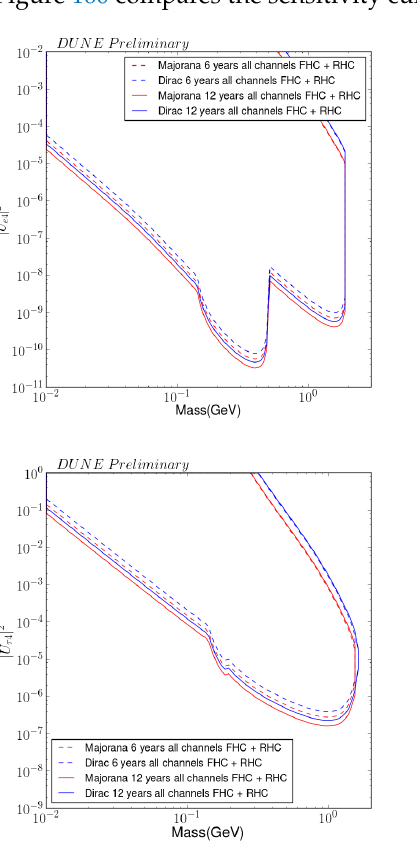
Figure 159. The 90% confidence level (CL) sensitivity regions for dominant mixings 2 are presented for DUNE ND. Sensitivity curves are shown that are reached after 6 and U τ N and | | 12 years of data taking using an equal amount of beam time in the neutrino and anti-neutrino configuration. The regions are a combination of the sensitivity to HNL decay channels with good ν ee , ν e µ , νµµ , νπ 0 , e π , and µπ . The study is performed for detection prospects. These are HNL → Majorana neutrinos (solid) and Dirac neutrinos (dashed), assuming no